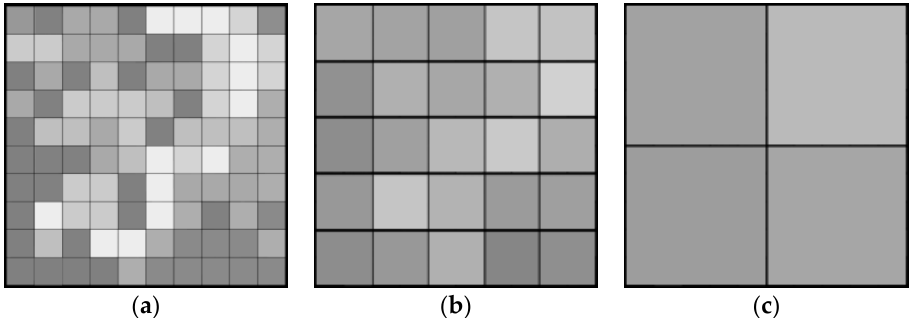
Figure 1. Steps of image analysis. ( a ) Example of pixels in 2 d picture; ( b ) grouped pixels at scale k = 2; ( c ) grouped pixels at scale k = 5 used to calculate the climacogram.